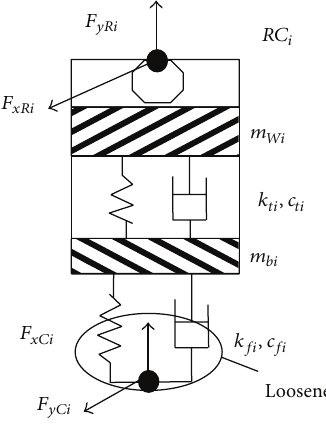
Figure 3: Rotor-casing